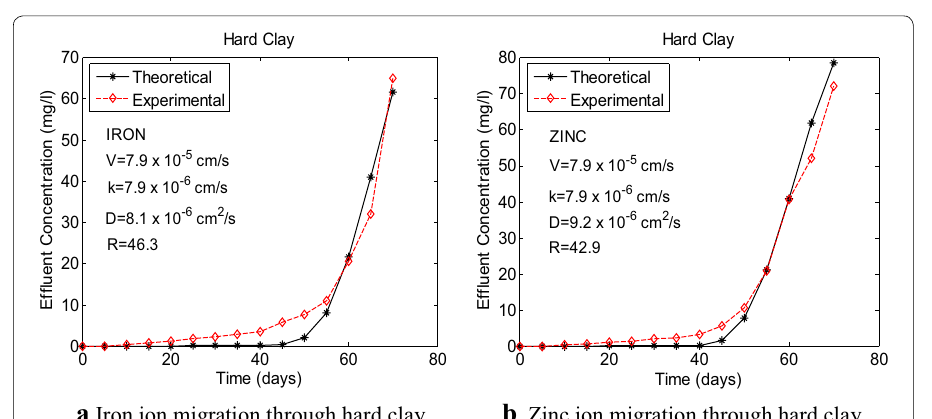
Zinc ion migration through hard clay Fig. 8 Migration of ions through hard